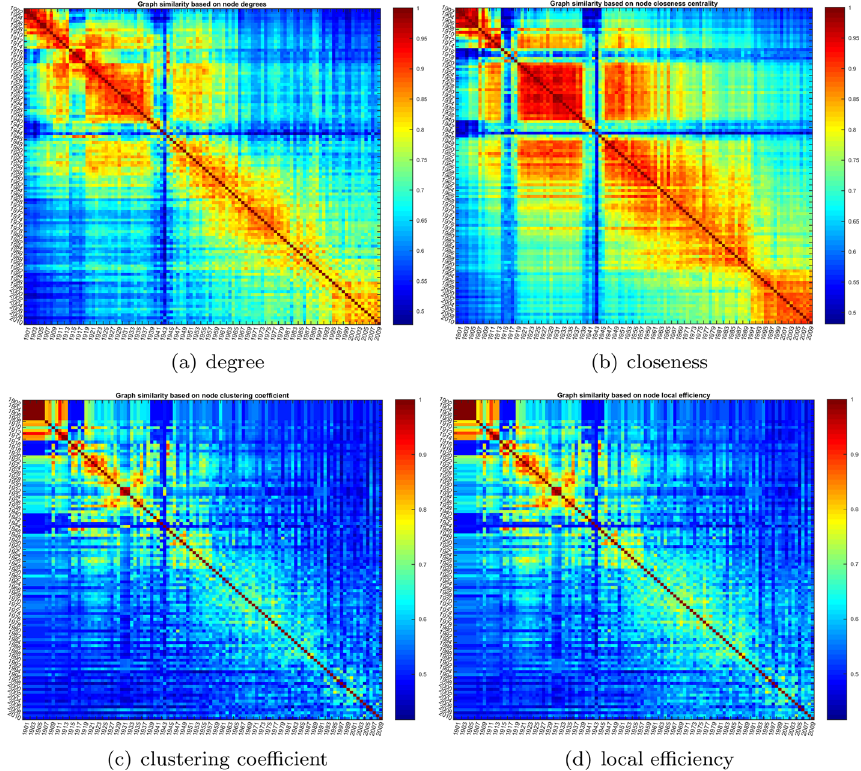
Fig. 13 Graph similarity matrices based on node-level graph measures. Similarity matrix based on ( a ) node degree ( b ) node closeness ( c ) node clustering coefficient ( d ) node local efficiency